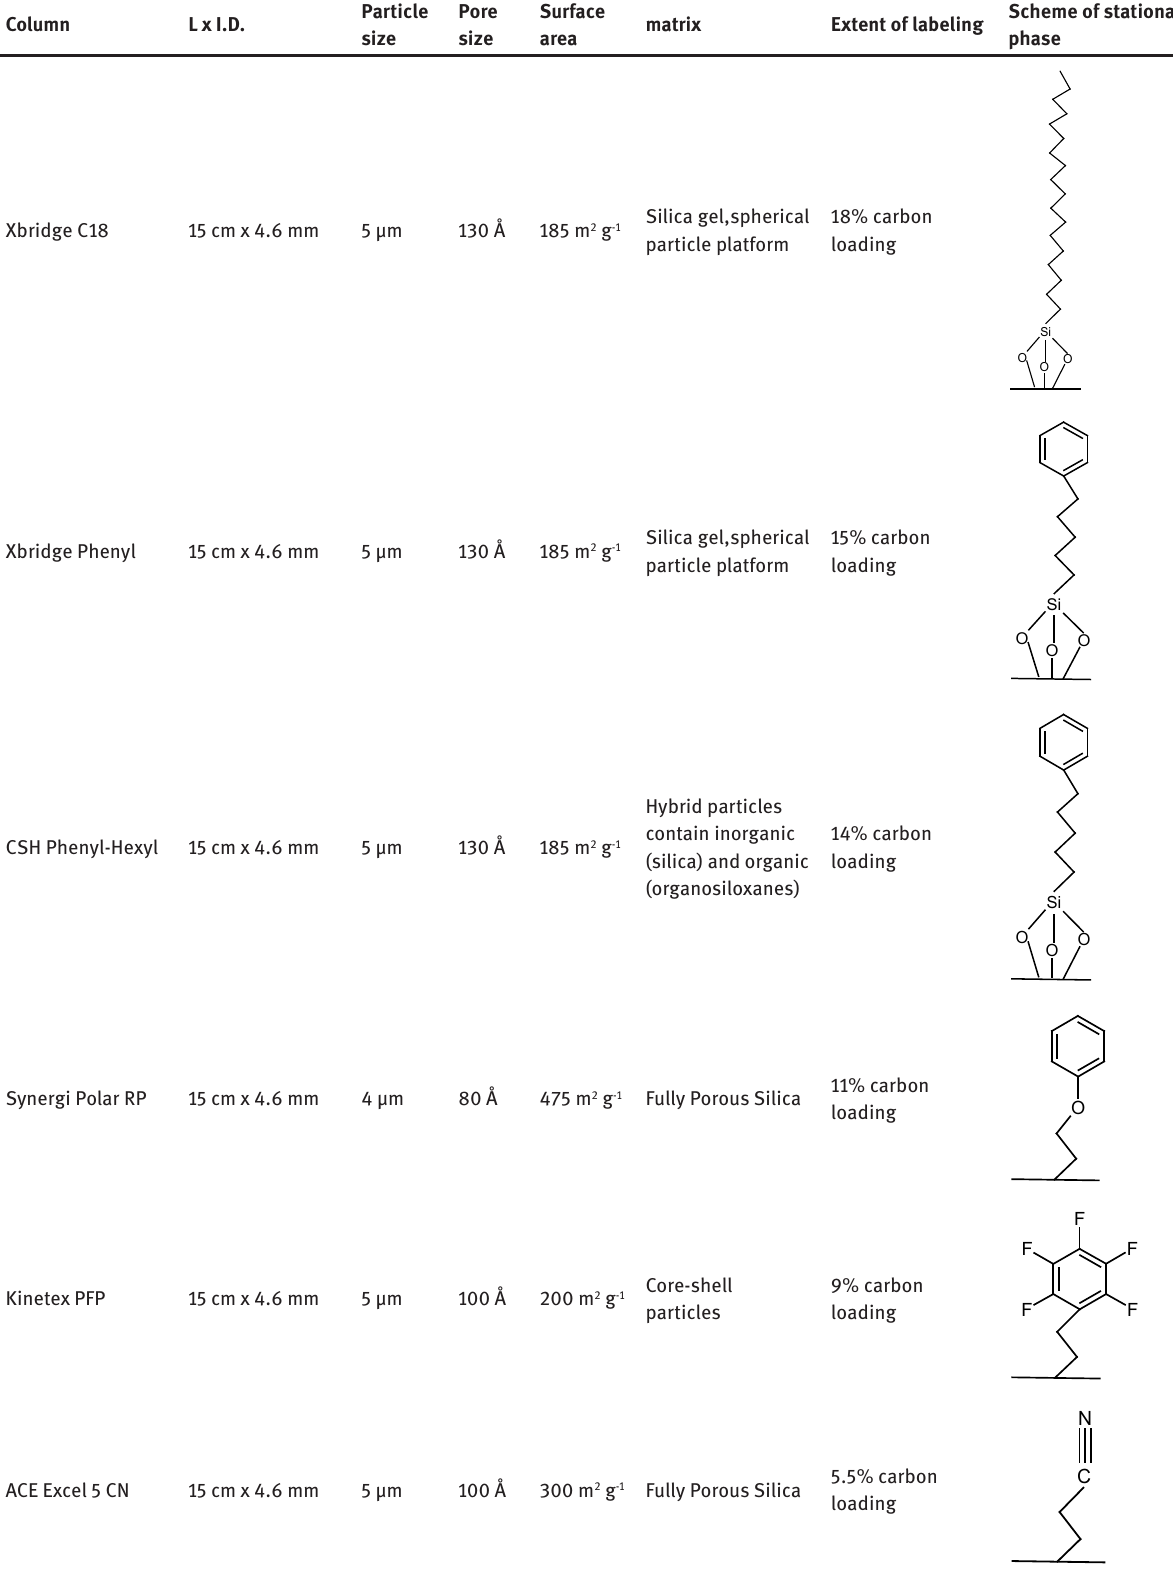
Table 1: List of tested columns and their physicochemical properties.